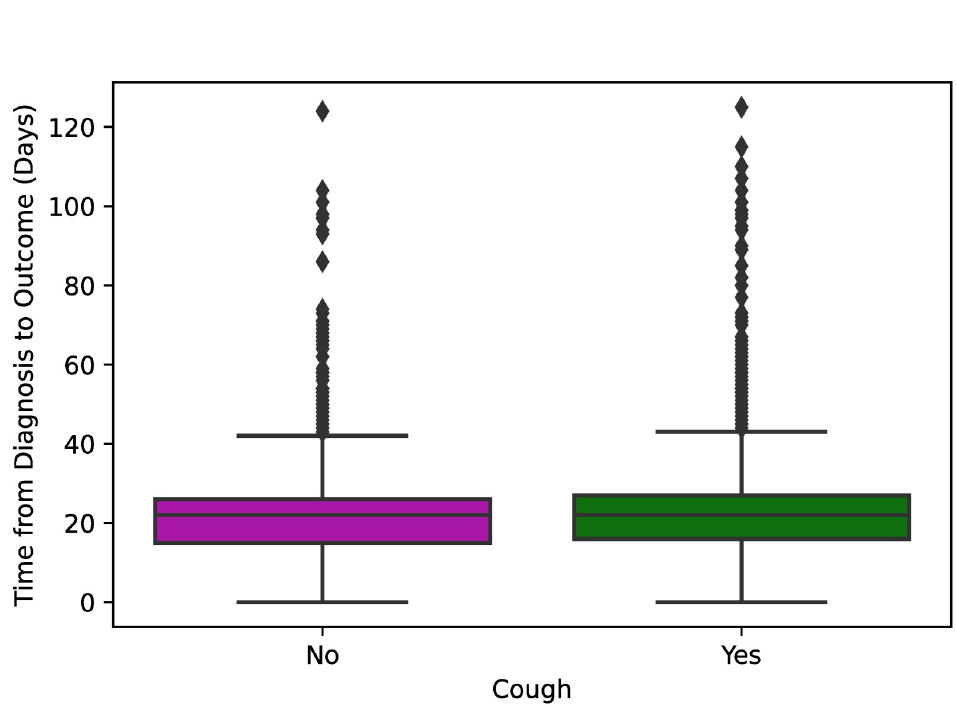
Fig 4. Box plot showing the time from diagnosis to definitive outcome between hospitalized COVID-19 patients that reported and did not report cough as an initial symptom of COVID-19. One-way ANOVA was used to estimate a significant p-value < 0.001 for those